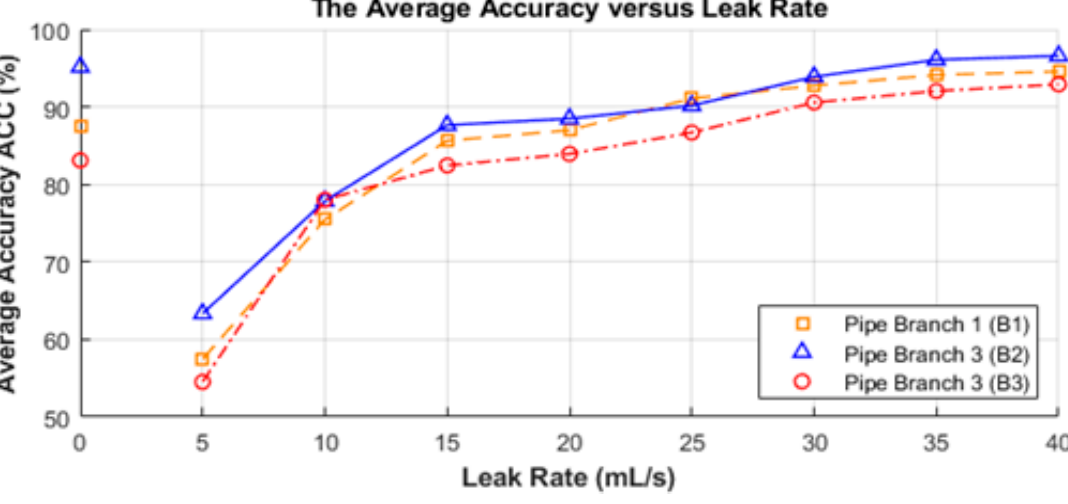
Figure 6. Performance evaluation of MC-MLI under different leak rates.